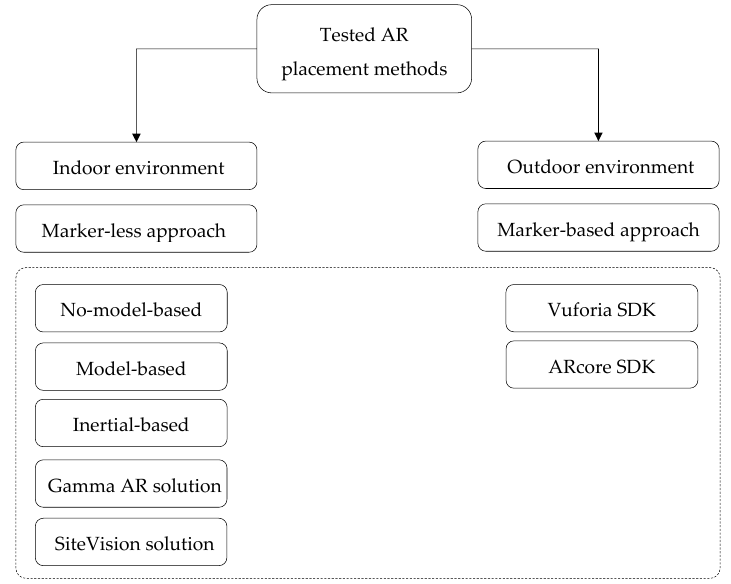
Figure 7. The AR placement methods object of our study.